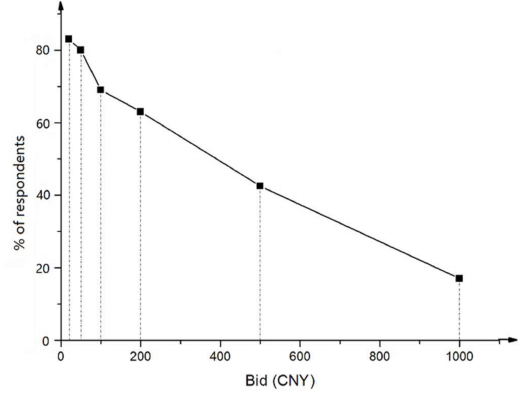
Figure 1. The percentage of “yes” responses to the WTP